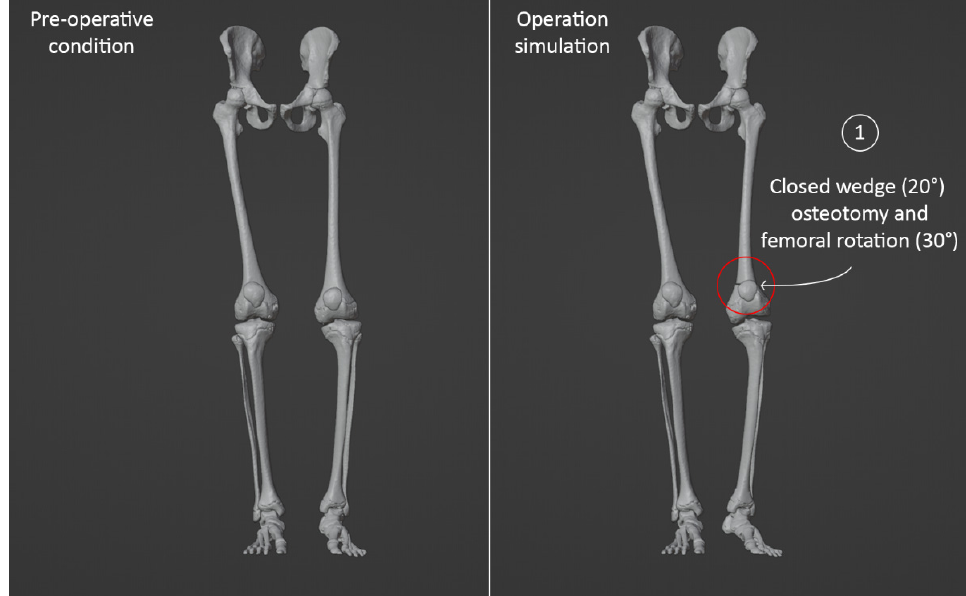
Figure 11. Comparison between the baseline appearance of the 3D model and the same model after simulating the femoral extension-derotation osteotomy. The patella is pointing forward, but the foot is pointing outward.